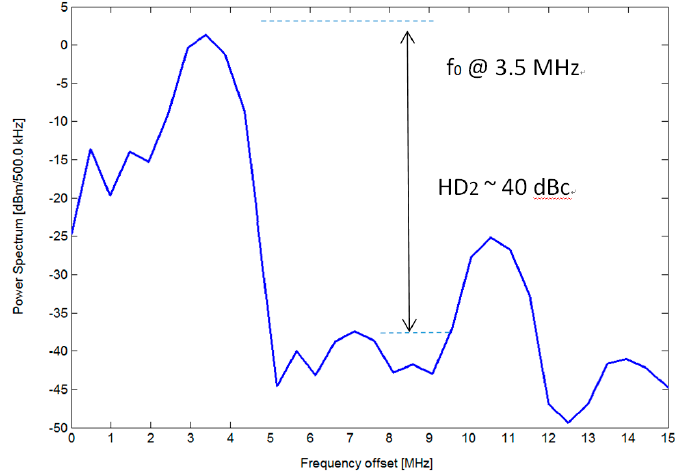
Figure 20. Spectrum analysis of the measured output pulses in Figure 19. Table 2. Measured power consumption of the ultrasound pulse driver per channel in the excitation mode (excitation rate = 1% of the pulse repetitive frequency). Input Signal Frequency.